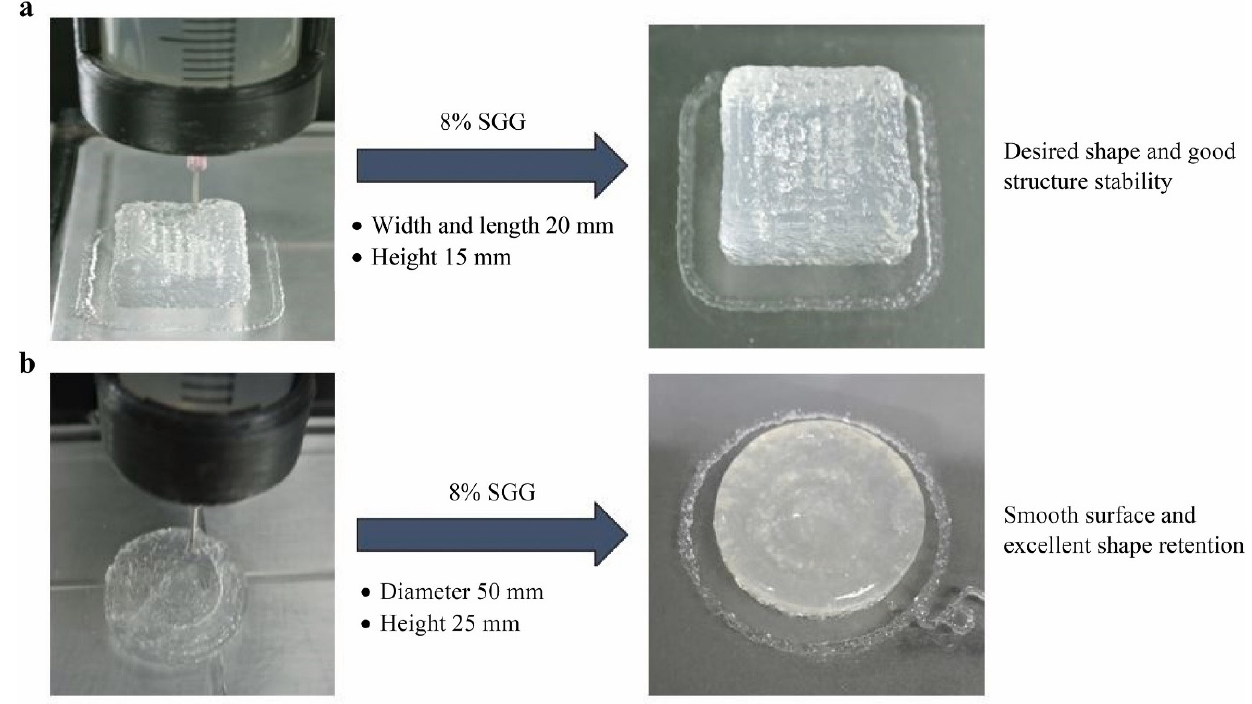
Figure 5. 3D-printed salmon gelatin gel (SGG) with the desired shape. ( a ) cube, ( b ) cylinder.“Reprinted/adapted with permission from Ref. [61]. Copyright © 2021, Elsevier”.